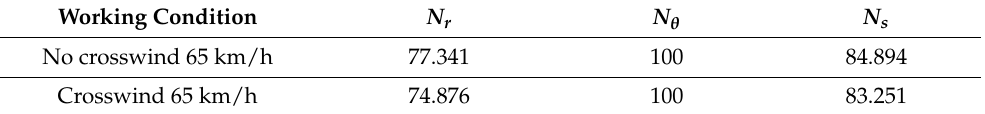
Figure 18. Comparison curves and difference curves of crosswind offset velocity with and without crosswind action. Table 10. Performance index score of snaking test with and without crosswind effect. Working